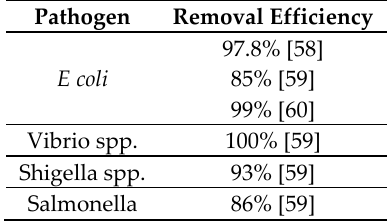
Table 7. Pathogen removal efficiency for ceramic water filters.